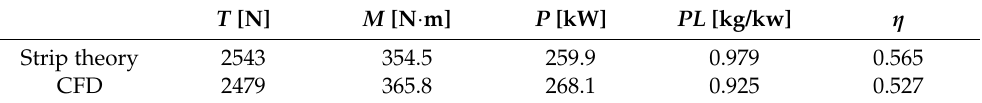
Table 2. Comparison of the results from the strip theory method and CFD simulation.